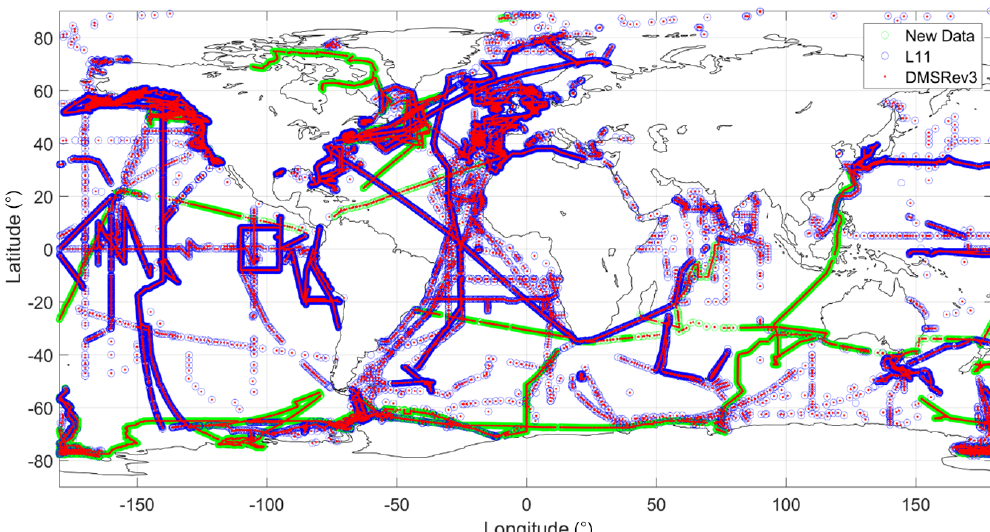
Figure 1. Data from different sources were put together for creating the raw input dataset, which consisted of 873539 points. The data in blue circles represent data that were used in the L11 DMS climatology, and the green represent the new data. Post quality control, and data unification for addressing temporal and spatial sampling biases, 48898 data points were used as an input for the DMS-Rev3 climatology calculation algorithm (red